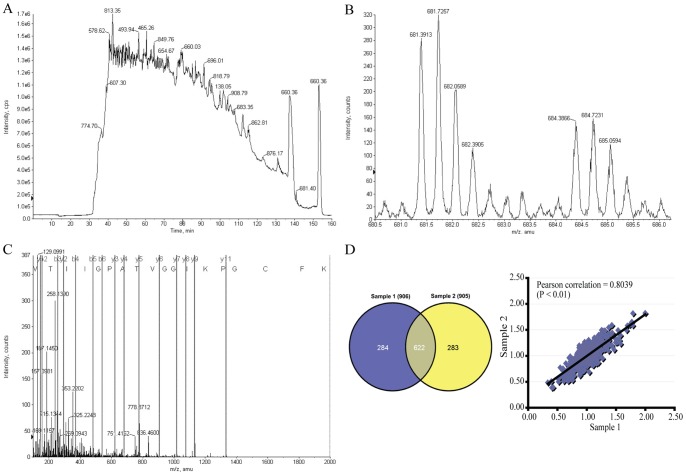
Protein samples from LX2/miR-27a and LX2/miR-neg were compared by cleavable isotope-coded affinity tag (cICAT)-based quantitative proteomic analysis - identification and quantitation of ATP-citrate synthase.(A) Total ion chromatogram (TIC) indicating cICAT-labeled peptides eluting from a reverse phase column. (B) Expanded MS spectrum view of a pair of peaks showing the differential expression between peptides labeled with the isotopically light and heavy cICAT reagent. (C) MS/MS spectrum analysis of the light-cICAT labeled triply charged peptide (681.4 m/z) showed in (B) led to identification of a peptide with sequence GVTIIGPATVGGIKPGCFK (ICAT-C(C)@17), unique to the ATP-citrate synthase (ACLY), a predicted target of miR-27a. The labels b and y designated the N- and C- terminal fragments, respectively, of the peptide produced by breakage at the peptide bond in the mass spectrometer. The number represents the number of N- or C- terminal residues present in the peptide fragment. (D) Venn diagram depicting the overlap of proteins identified in two independent cICAT experiments. Numbers in parentheses indicate the number of identified proteins for each sample. To examine the biological reproducibility, linear regression analyses were performed on H/L ratios (LX2/miR-27a/LX2/miR-neg) of two independent analyses. Pearson correlation coefficient between samples 1 and 2 was 0.8039, P<0.01.